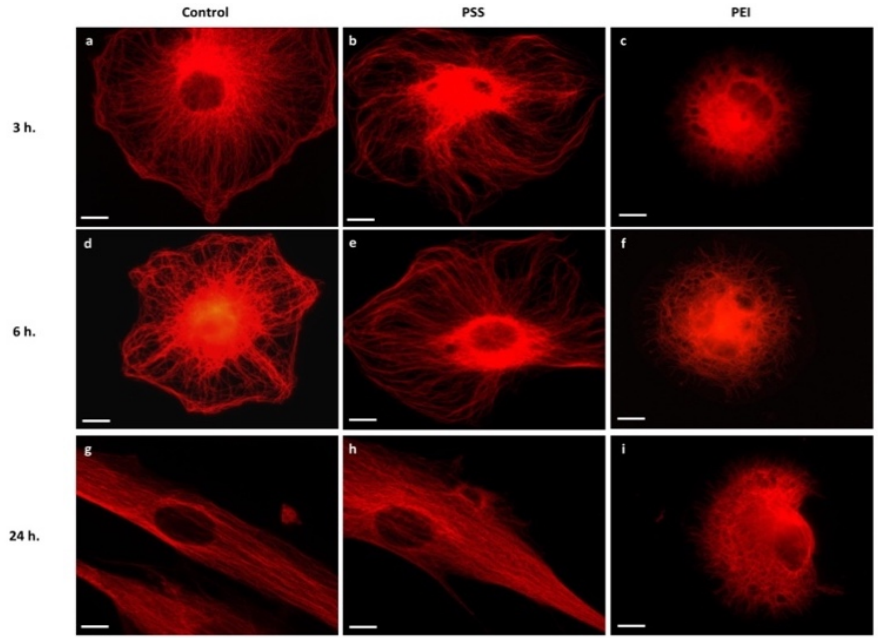
Figure 3. Representative images of cytoskeleton structure of MSCs after 3 h, 6 h, and 24 h of culture time on glass slides ( a , d , g ), PSS-ended slides ( b , e , h ), and PEI-ended ( c , f , i ) slides. Red represents anti α -tubulin and Alexa Fluor 594 stain of microtubules. Scale bar: 2 μ m.